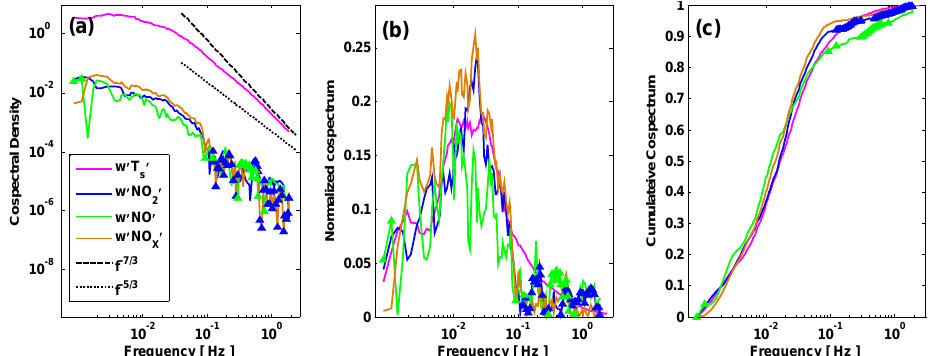
Figure 4. Equally spaced logarithmic averaged (150 bins) absolute cospectral density (a) , frequency weighted cospectrum (b) , and normalized cumulative distributions of the cospectra of temperature (magenta) NO (green), NO 2 (blue) and NO x (yellow) (c) with vertical wind from 11:00–12:00 through out the whole field campaign when the chemical perturbation is small. Closed triangles represent the absolute value of the negative cospectral density, which has the opposite sign to the general flux direction. The black dotted lines in (a) are lines with slopes of − 7/3 and − 5/3 (see related text).